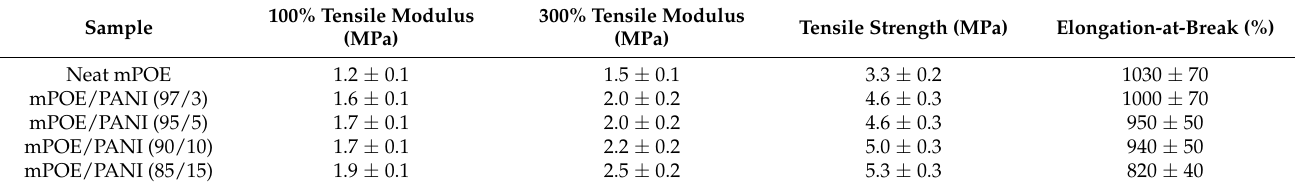
Figure 4. Stress–strain curves of mPOE/ PANI blends. Table 2. Tensile properties of mPOE/PANI blends.